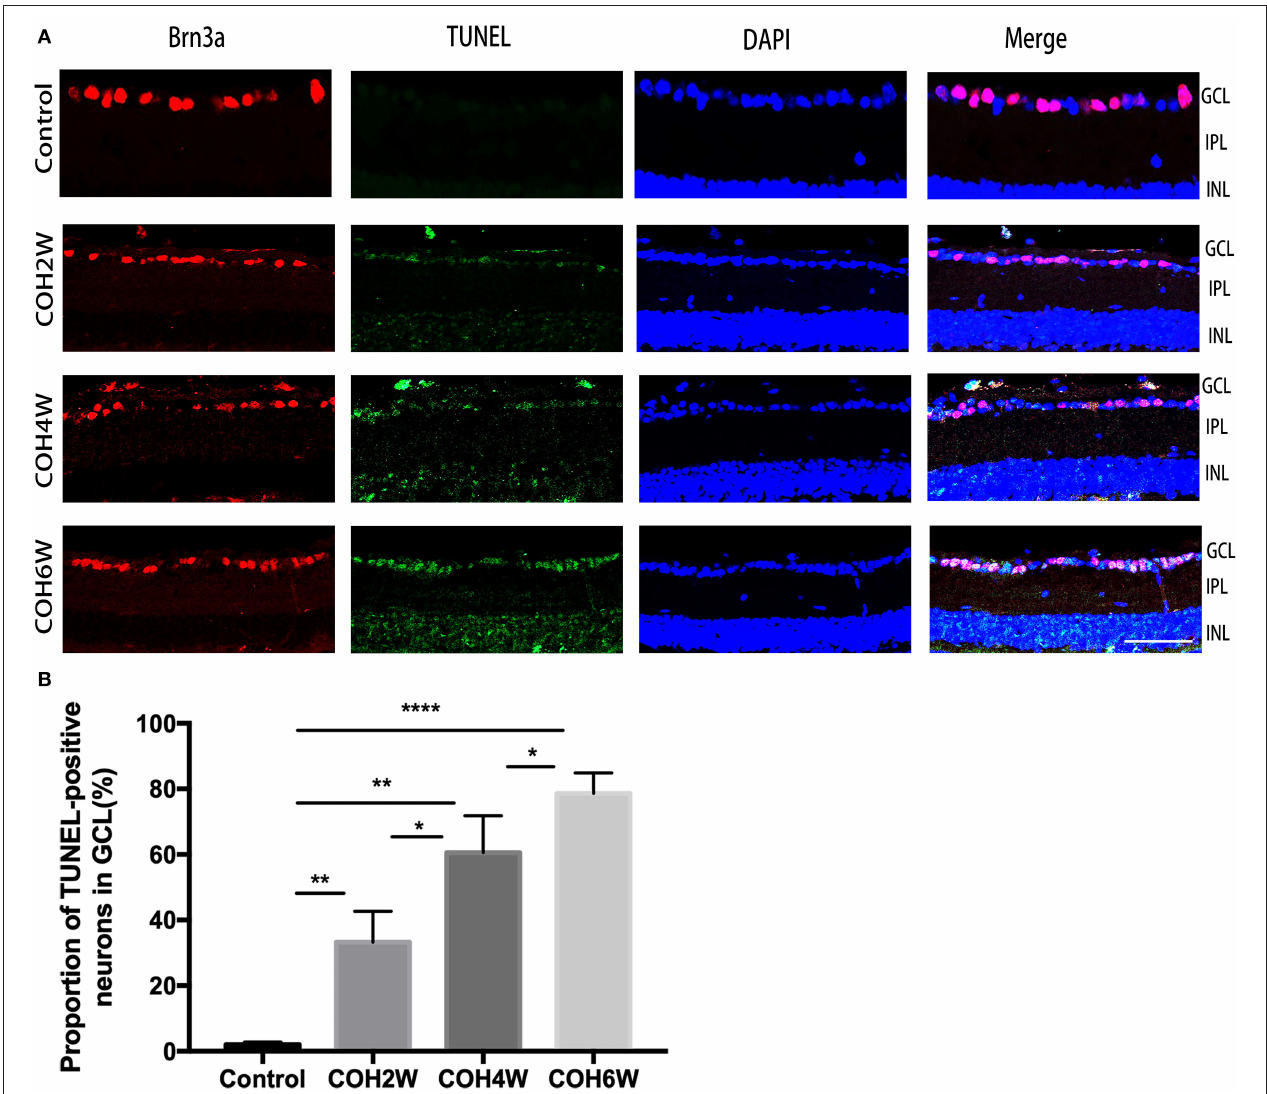
FIGURE 7 | Apoptosis of neurons in the ganglion cell layer (GCL) was obvious after intracameral injection of cross-linking hydrogel. (A) Representative images of TUNEL (green fluorescence) and Brn3a (red fluorescence) double-staining for apoptosis evaluation of neurons in the GCL of different groups (magnification × 200, scale bar = 50 µ m). Cell nuclei were marked with DAPI (blue). (B) Quantitative analysis of proportions of TUNEL-positive cells to Brn3a-positive cells in the GCL (* p < 0.05, ** p < 0.01, and **** p < 0.0001). Data were analyzed using one-way ANOVA followed by Tukey’s post hoc test. N = 24 mice (control group: 6 mice; hydrogel injection group: 18 mice). Bars represent mean ± SD.